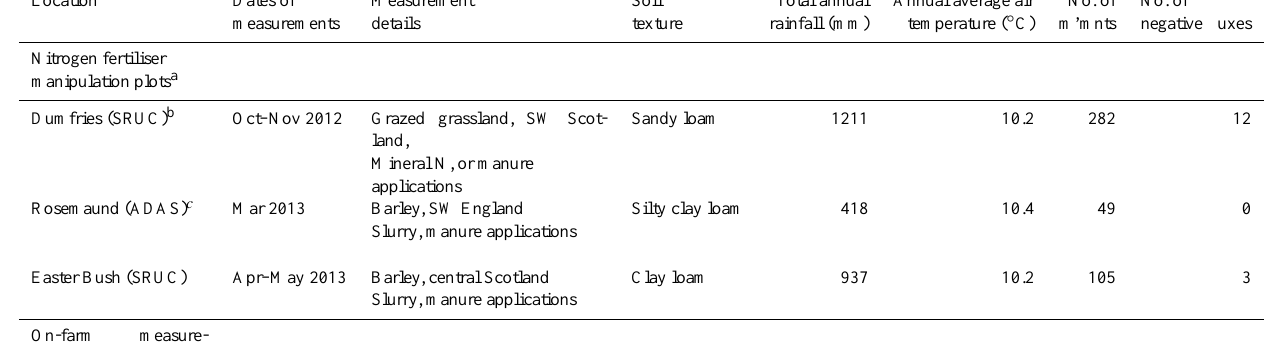
Table 1. A summary of all InveN 2 Ory field sites from which N 2 O fluxes were made using the dynamic chamber method. Location